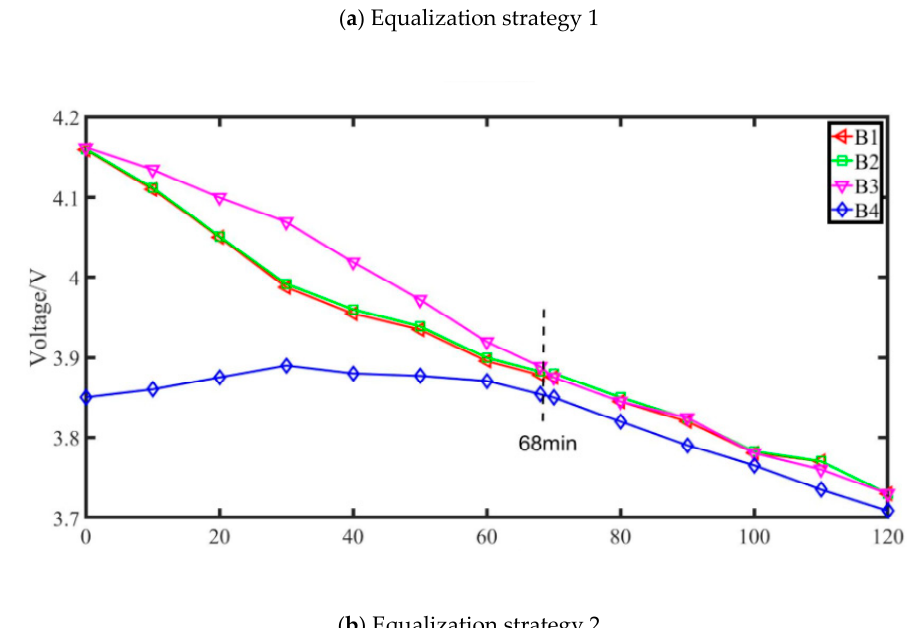
Figure 18. Experimental results of active equalization in discharging state.